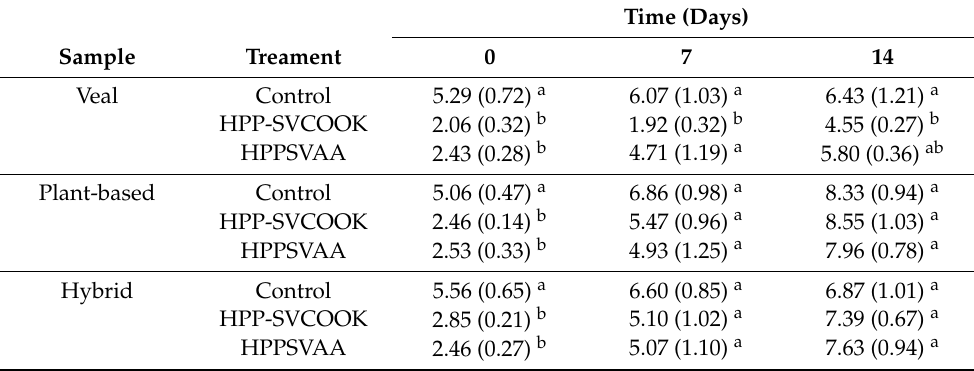
Table 5. Lactic acid bacteria counts (mean of log cfu/g (standard deviation)) in the veal, plant-based, and hybrid patties during the 0, 7, and 14 days after processing.